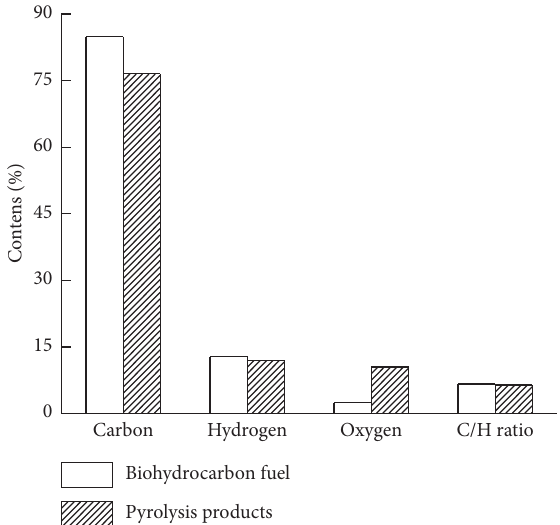
Figure 14: Element analysis of pyrolysis products and biohydrocarbon